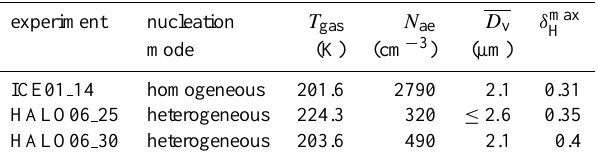
Table 1. Overview of the AIDA ice cloud nucleation experiments with small ice particles. T gas and N ae represent initial conditions of the mean gas temperature and the aerosol number concentration, respectively. D v gives the median particle diameter at maximum depolarisation ratio δ max detected by SIMONE. Note that in case of H HALO06 30 the maximum depolarisation ratio was detected during ice particle